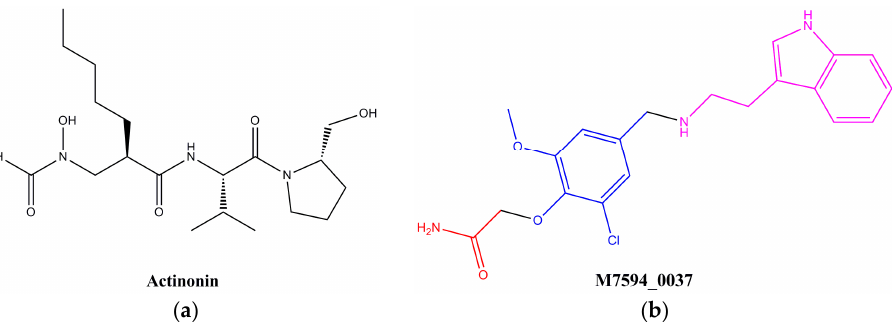
Figure 1. Structures of PDF inhibitor actinonin ( a ) and the shortlisted compound M7594_0037 ( b ).